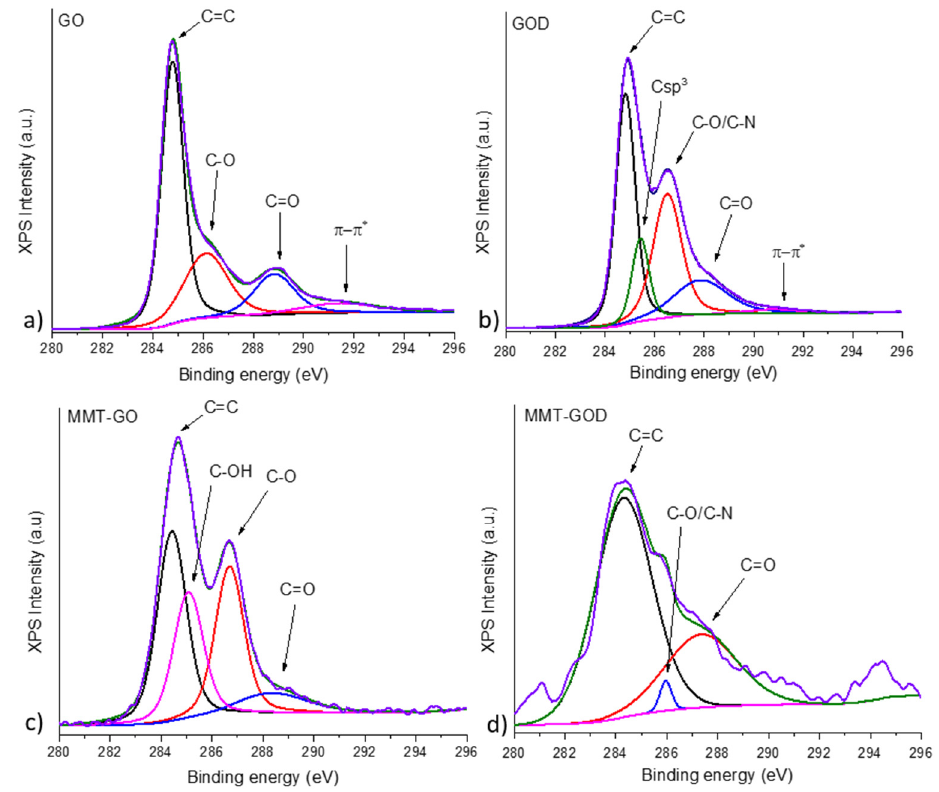
Figure 2. C1s high-resolution spectra for a ) GO, b ) GOD, c ) MMT–GO and d ) MMT–GOD